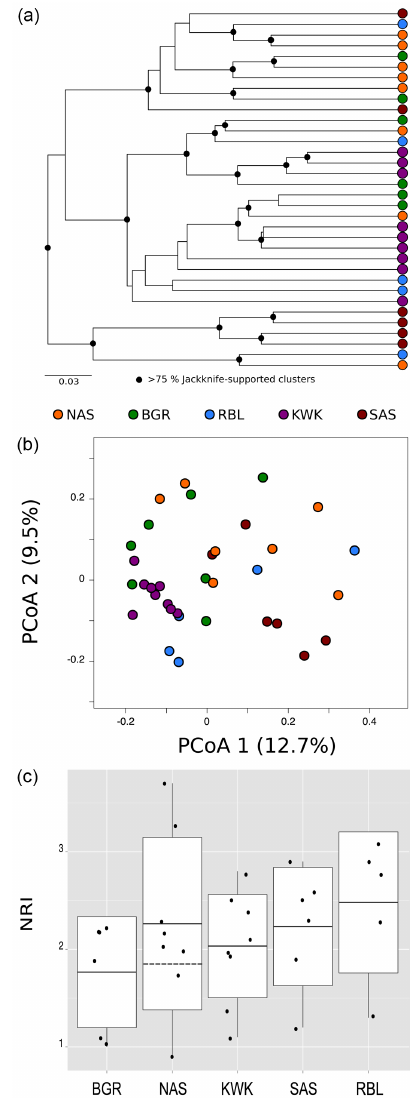
Figure 1. (a) UPGMA clustering based on weighted and nor- malized UniFrac distances among bacterial community samples. Clustering statistics were computed using 100 jackknife replicates. (b) Principal coordinate analysis (PCoA) using UniFrac weighted distance metric. The SAS and KWK valleys are located in sporadic (highly degraded) permafrost landscapes, while the NAS and BGR valleys are located in discontinuous (less degraded) permafrost landscapes, and reference rock-based lakes are located in the RBL valleys. (c) Differences in the phylogenetic structure (NRI, net relat- edness index) of bacterial communities among the different valleys. The solid black horizontal and vertical lines represent the mean and SD, respectively. The dashed line represents the mean NRI value of NAS valley, with the two outliers excluded. Black dots represent individual ponds and